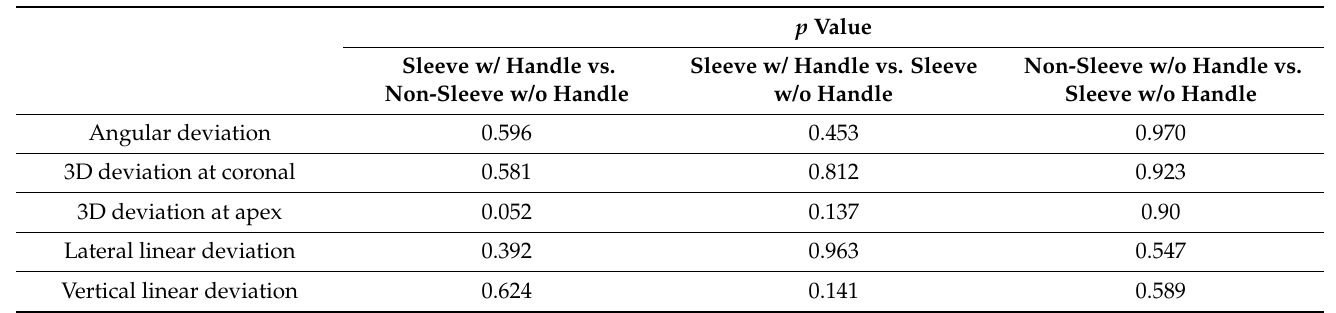
Table 7. The multiple comparisons in the accuracy of implant placement in three types of surgi- cal guides.